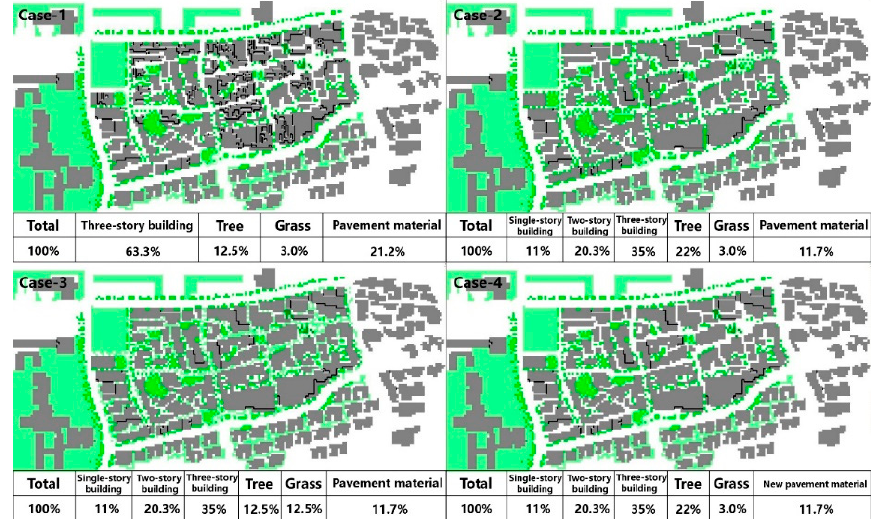
Figure 17. The new cases: Various types of different coverage ratios.